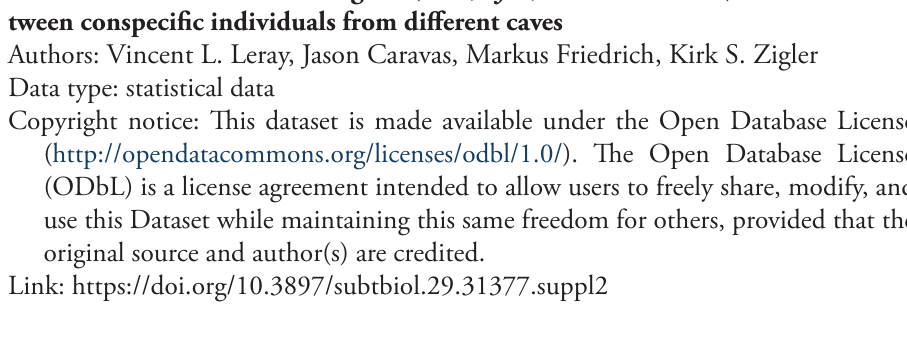
Table S2. Mean cox1 and five gene ( cox1 , cytb , rrnL-trnL-nad1 ) P-distances be- tween conspecific individuals from different caves